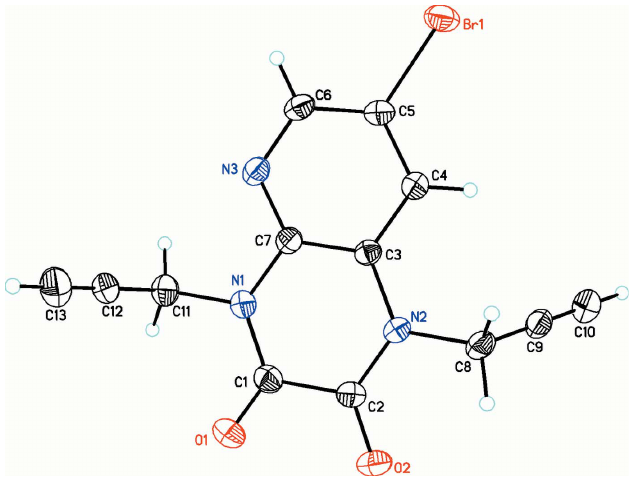
Figure 1 Aview of the molecular structure, showing displacement ellipsoids drawn at the 30% probability level.